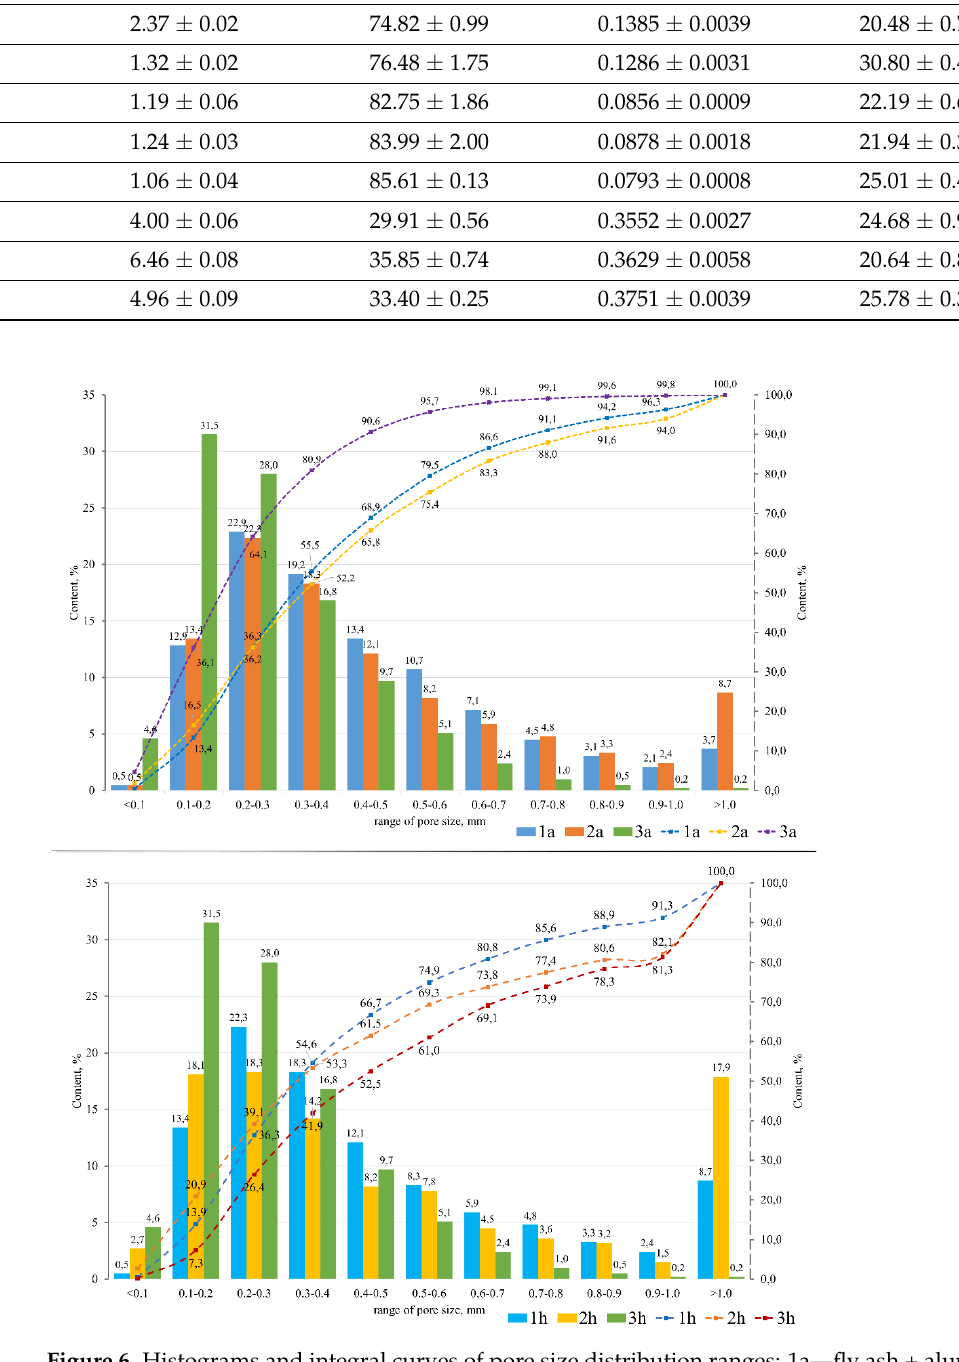
Figure 6. Histograms and integral curves of pore size distribution ranges: 1a—fly ash + aluminum powder; 1h—fly ash + hydrogen peroxide; 2a—fuel slag + aluminum powder; 2h—fuel slag + hydrogen peroxide; 3a—ASM + aluminum powder; 3h—ASM + hydrogen peroxide.